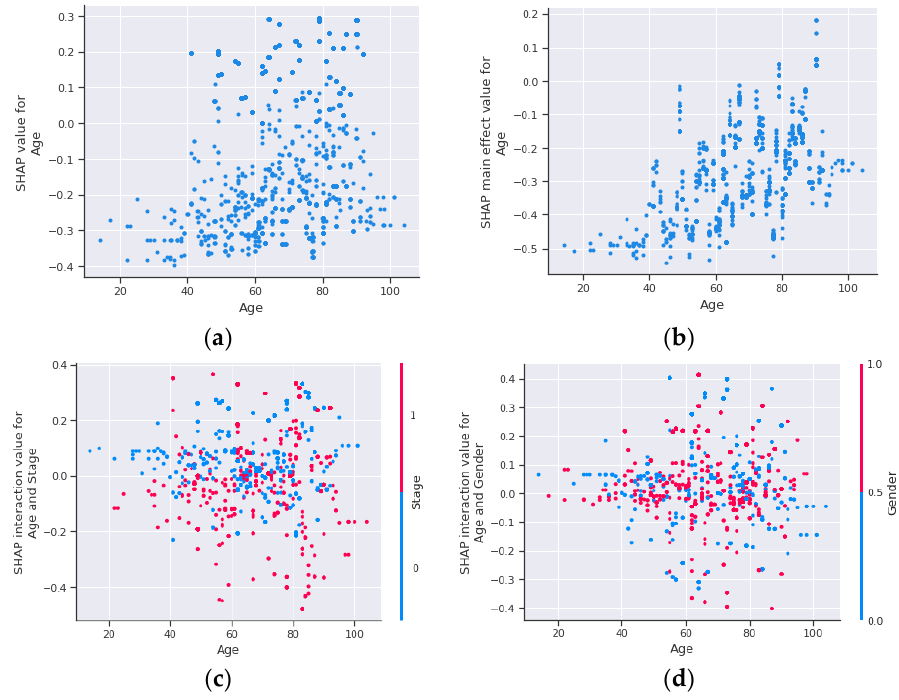
Figure 8. Dependence plots of the SHAP interaction values between age and other important features: ( a ) SHAP value of age; ( b ) SHAP main effect value of age; ( c ) SHAP interaction value between age and stage; and ( d ) SHAP interaction value between age and gender.